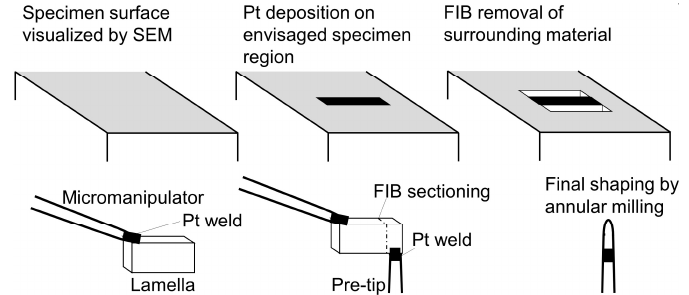
Figure 4. Scheme of the atom probe tomography (APT) specimen preparation by lift-out technique.